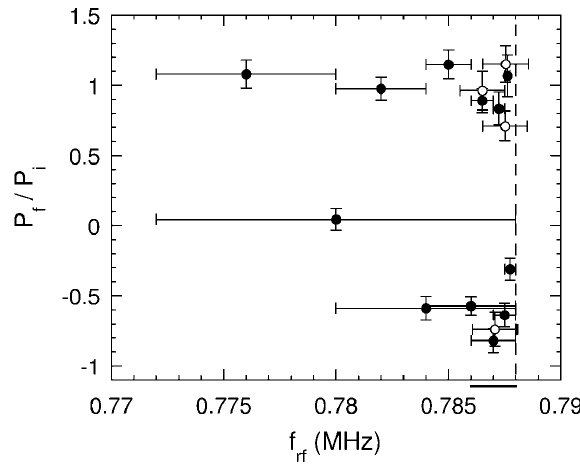
FIG. 2. The ratio of the electron beam’s final polarization to its initial polarization at 669.2 MeV is plotted against the center of the frequency ramp. The solid circles show the resonance search data, while the open circles represent the additional data with frequency ranges of 6 1 kHz. The horizontal bars show the ranges of the frequency ramps; the dashed line shows 1